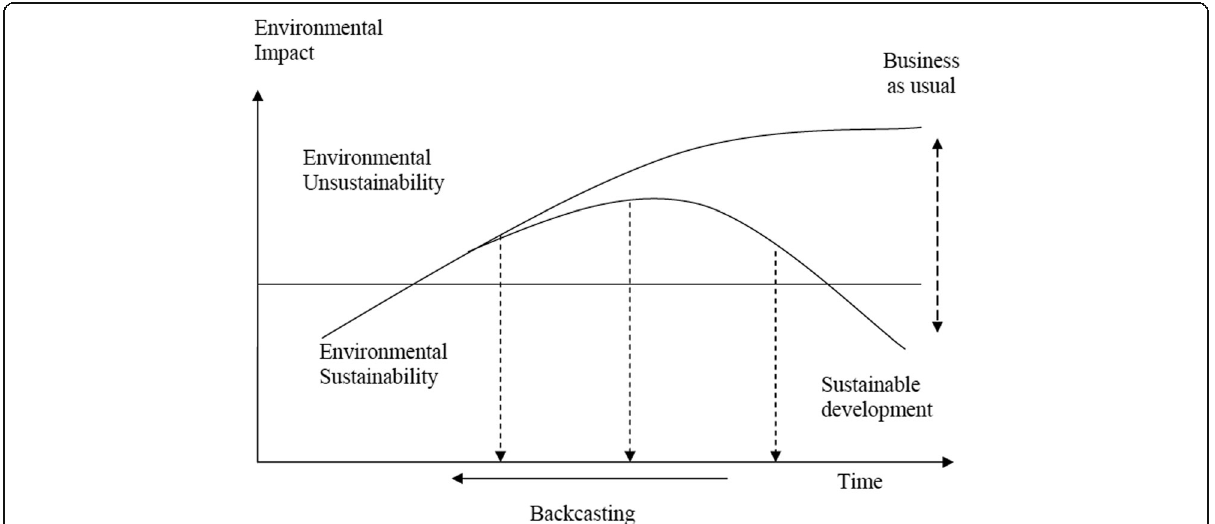
Fig. 1 Backcasting and forecasting approaches in a sustainability framework. Source: Banister [6]. Figure 1 summarizes the backcasting approach in comparison with the forecasting approach in a sustainability